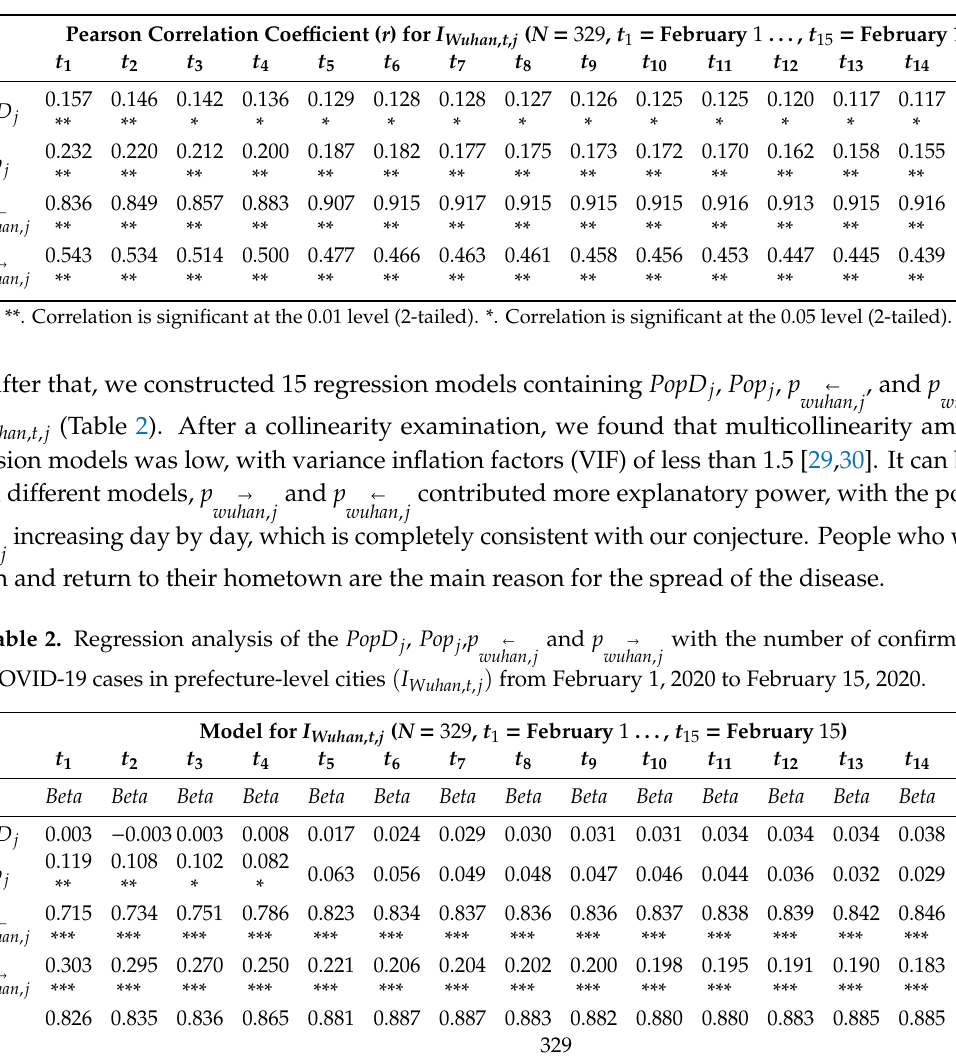
Table 1. Results of bivariate analysis ( r ) of PopD j , Pop j , p ←